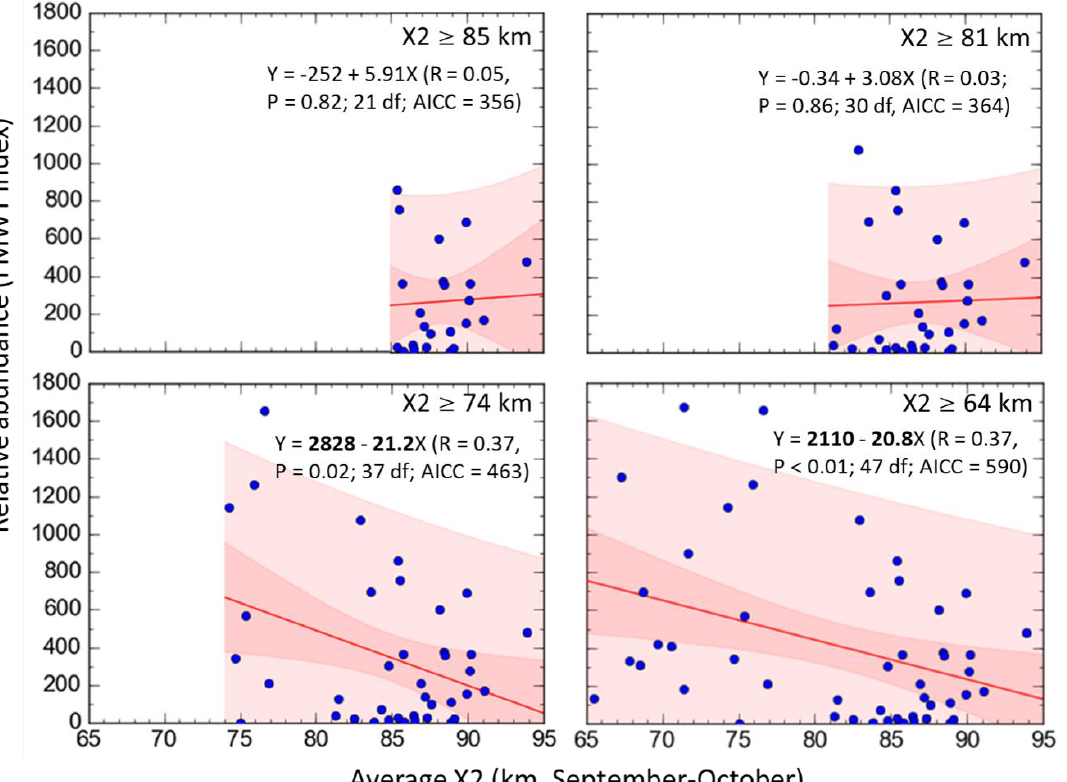
Figure 8. Relative abundance for subadult delta smelt based on the fall midwater trawl (FMWT) index (Y) versus the average position of the 2 psu isohaline (X2) during September and October (X) under four ranges of X2 over the period 1967–2017. Dark and light shaded areas denote 95% confidence intervals for regression lines and predicted values, respectively. Regression coefficients in bold type are significant (P < 0.05).